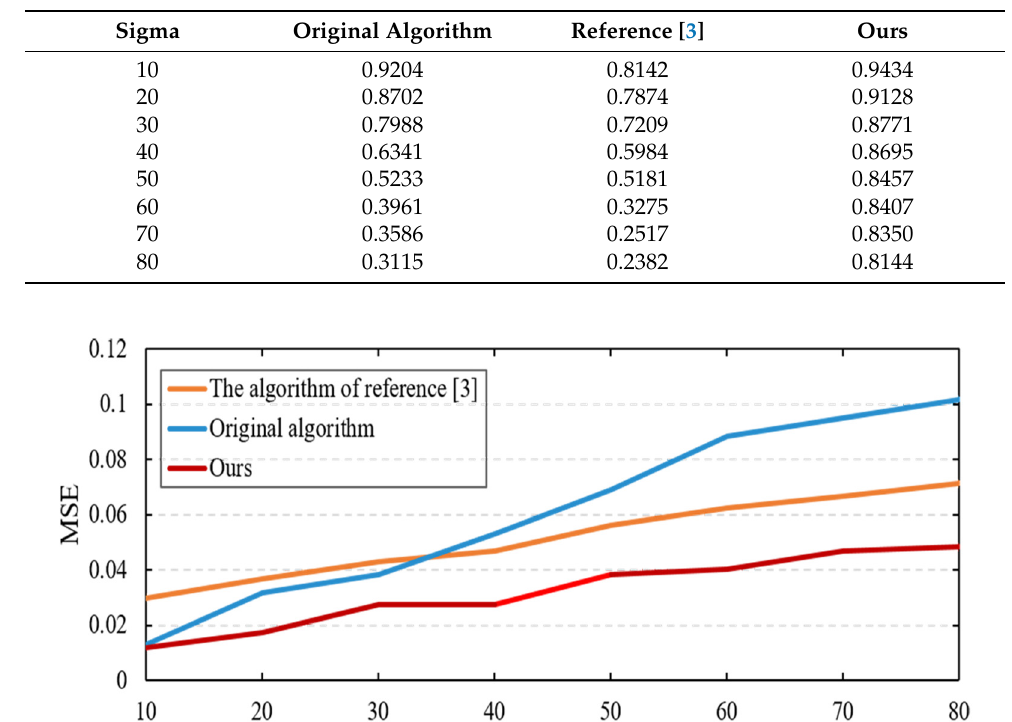
Figure 2. MSE line chart of the three algorithms for the Cameraman image.